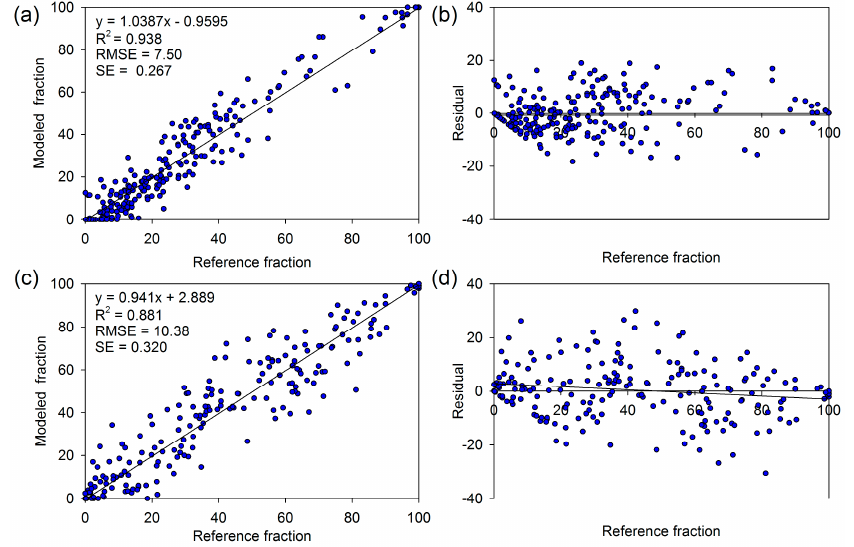
Figure 2. Results of the vegetation cover fraction (VCF) accuracy assessment for 2002 and 2013: ( a ) vegetation fraction scatter plot for 2013; ( b ) vegetation fraction residuals for 2013; ( c ) vegetation fraction scatter plot for 2002; and ( d ) vegetation fraction residuals for 2002.